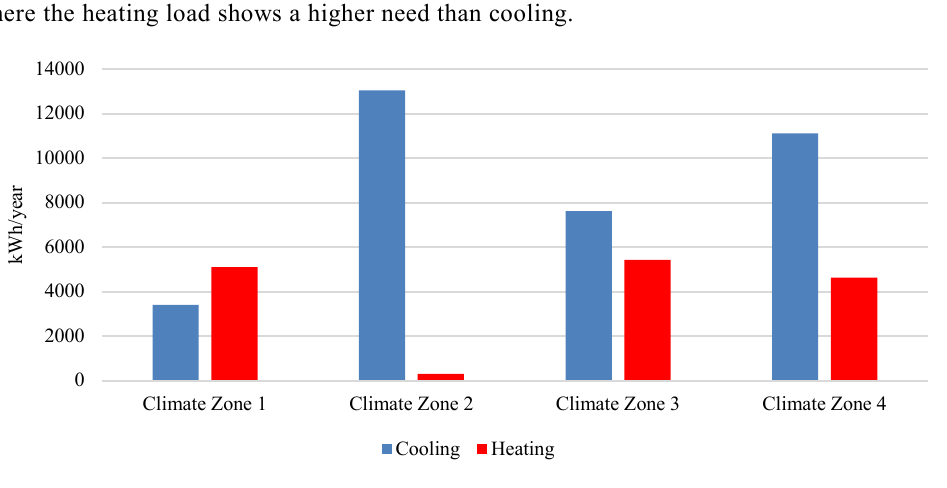
Fig. 2. Annual cooling and heating consumption in the baseline in different climate